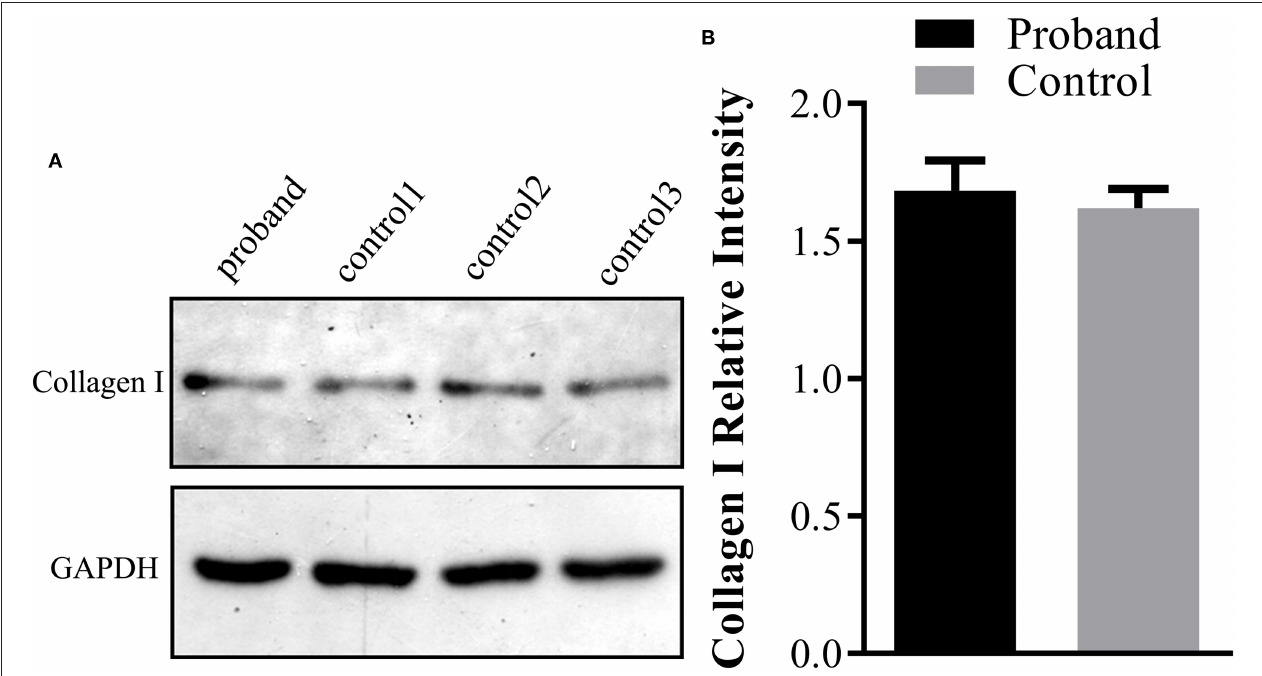
FIGURE 3 | Type I collagen production assay using Western blot analysis in the fetus. (A) The protein was extracted from the fetal abortion skin tissue for Western blot analysis, and three age-matched skin tissues without the COL1A1 mutation were used as the controls. (B) No significant reduction of the intracellular type I collagen product was observed in the proband compared with the control